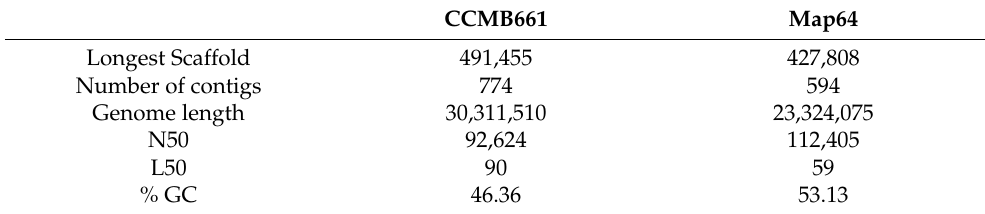
Table 1. Genome assembly statistics for the Ophiocordyceps australis CCMB661 and Map64